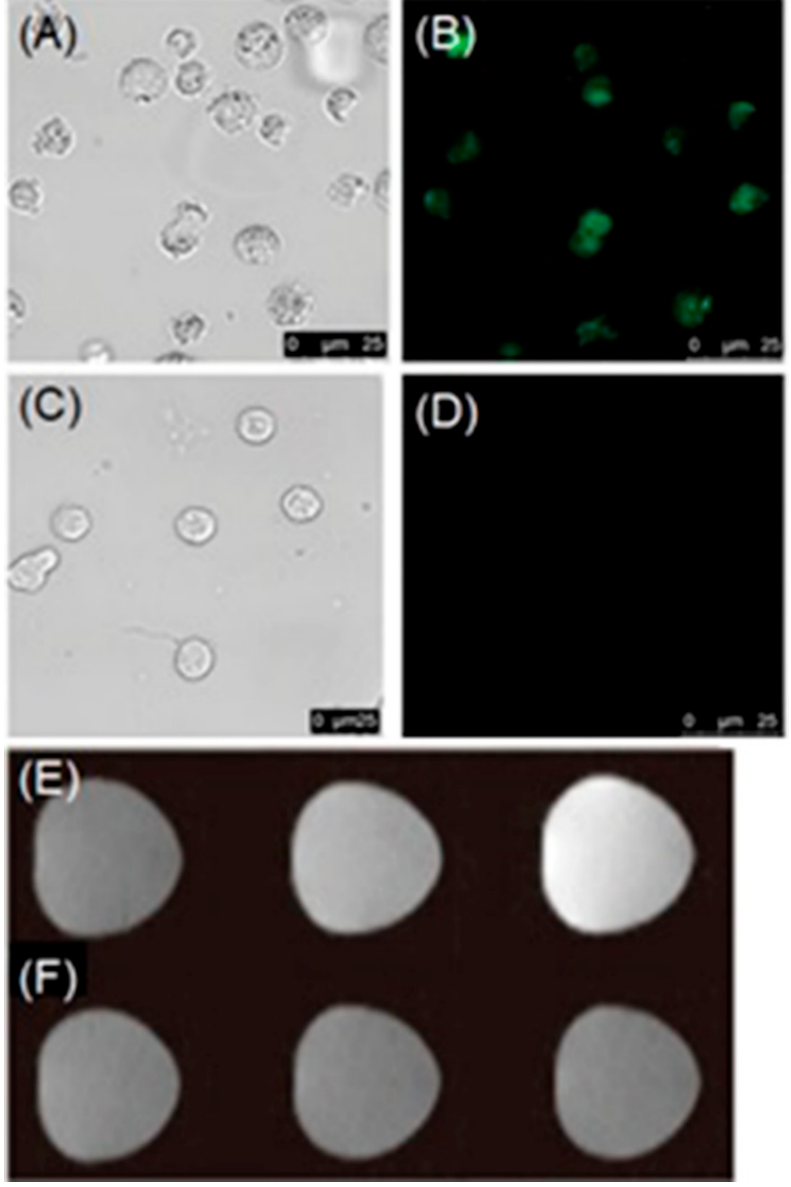
Figure 26. ( A , B ) Confocal microscopic images of CCRF-CEM cells and ( C , D ) Ramos cells treated with the nanoprobe, and the fluorescence signal amplified using rolling circle amplification. CCRF- CEM cells exhibited a green fluorescence compared to Ramos cells indicating that the fluorescence response of the nanoprobe was target cell-specific and activated by hypoxia. T 1 -weighted images of ( E ) CCRF-CEM cells and ( F ) Ramos cells incubated with the nanoprobe at various volumes (left to right: untreated, 30 µ L, and 100 µ L). CCRF-CEM cells exhibited more contrast enhancement in T 1 -weighted images compared to Ramos cells. These results were attributed to the target-cell recognition of the nanoprobe and reduction in MnO 2 by intracellular glutathione. Adapted with permission